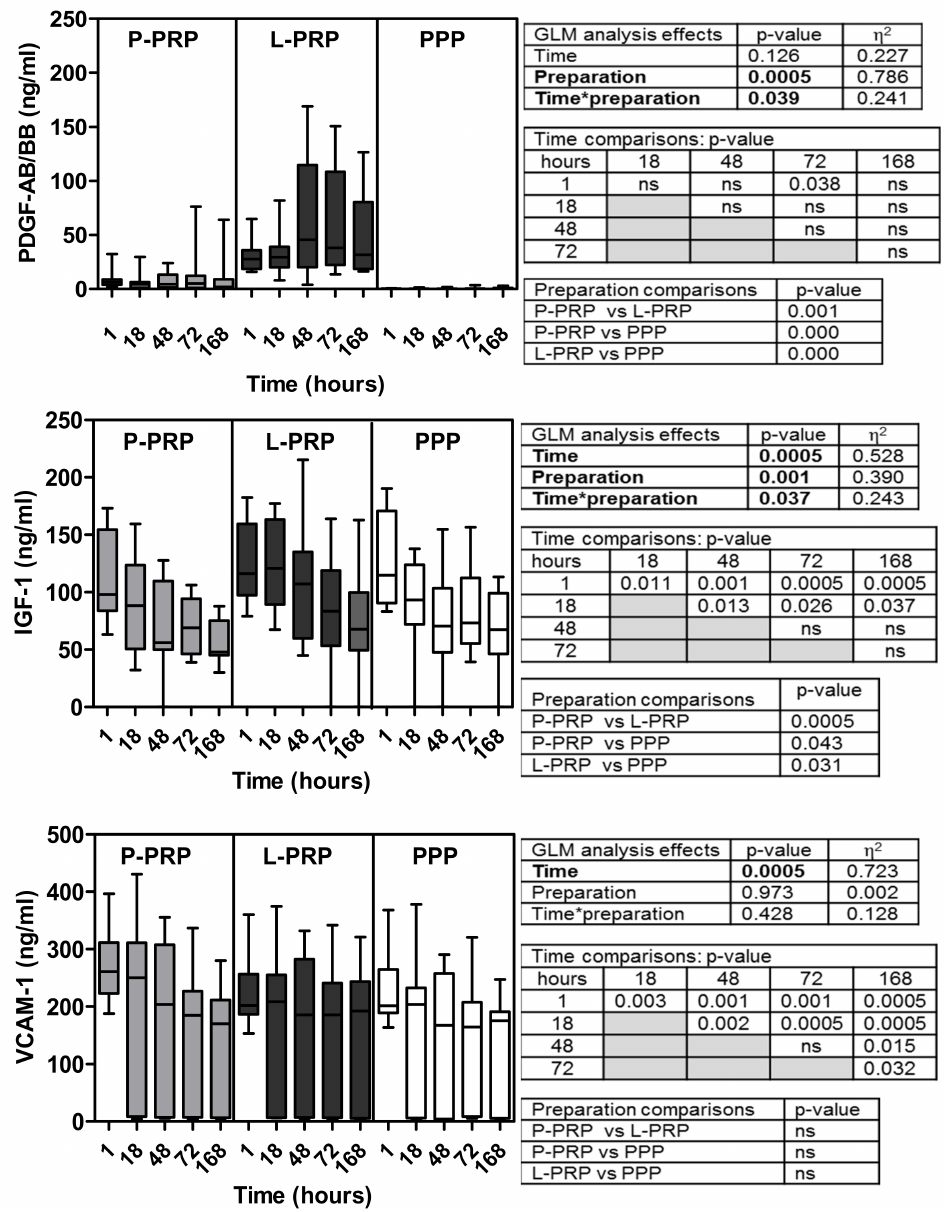
Figure 3. Concentrations of PDGF-AB/BB, IGF-1, and V-CAM-1 molecules in P-PRP, L-PRP, and PPP. Results are reported as medians (bars), 25th and 75th percentiles (boxes), and minimum to maximum values (whiskers); p value significances are reported in tables on the right side of each graph, as determined by general linear mode statistical analysis (bold); * variable association; ns, not